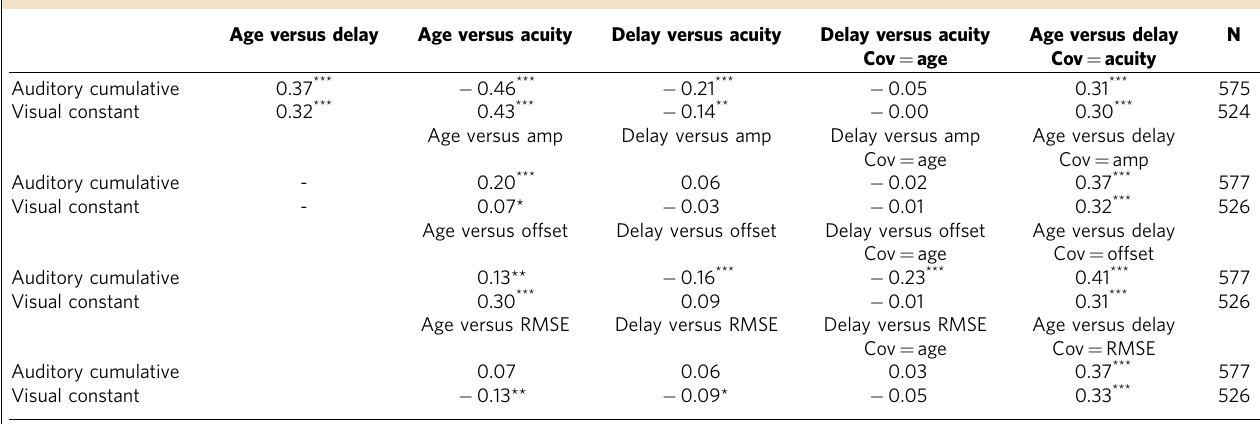
Table 2 | Tests for the effect of potential confounds on